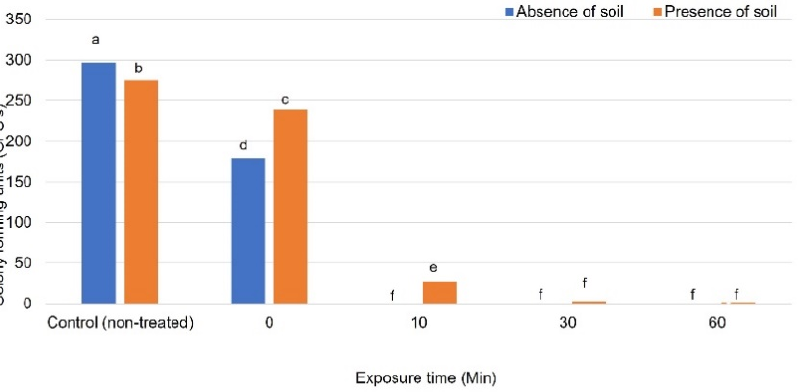
Figure 2. The survival of Fusarium oxysporum f. sp. cubense in water in the presence and absence of soil after treatment with ozone. Significant differences ( p ≤ 0.05) according to Tukey’s test are indicated by different letters.